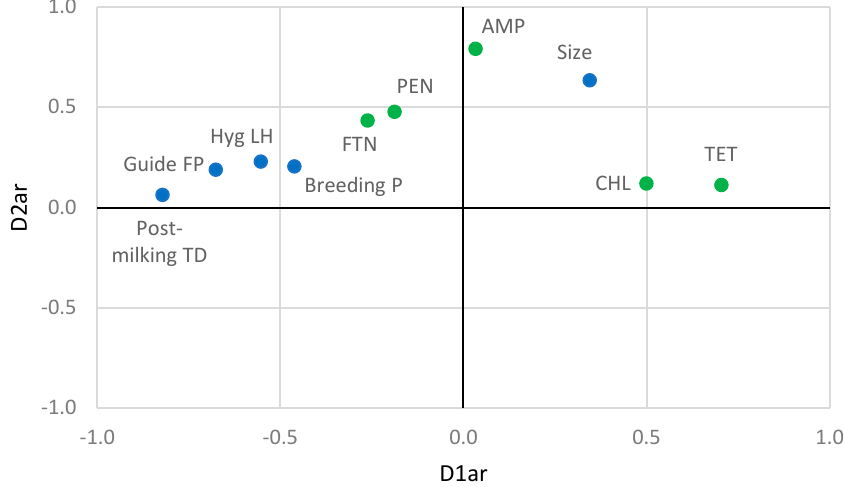
Figure 2. Nonlinear canonical correlation analysis similarity map determined by the first (D1ar) and second dimension (D2ar) for farming practices ( ● ) and antibiotic resistances ( ● ). Leyend: Size = flock size, Breeding P = Breeding program, Guide FP = guide to good farming practices, Hyg LH = hygiene of the livestock housing, Postmilking TD = Postdipping teat disinfection, AMP = ampicillin, PEN = penicillin, TET = tetracycline, FTN = nitrofurantoin, CHL = chloramphenicol.